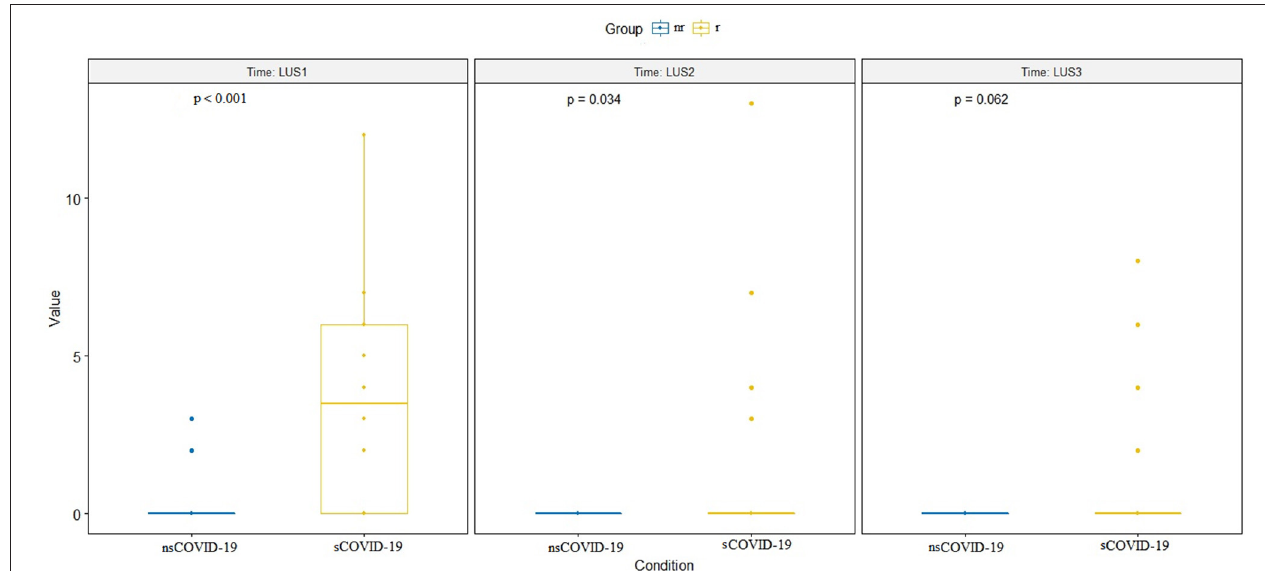
FIGURE 4 | Difference between LUS values at the three times of ultrasound evaluation (LUS1 = at time zero, at admission, LUS 2 = after 2 days and LUS3 = after 7 days). The difference is significant for the first two evaluations (respectively, p < 0.001 and p = 0.034) but not for the third evaluation ( p = 0.062). LUS, lung ultrasound.